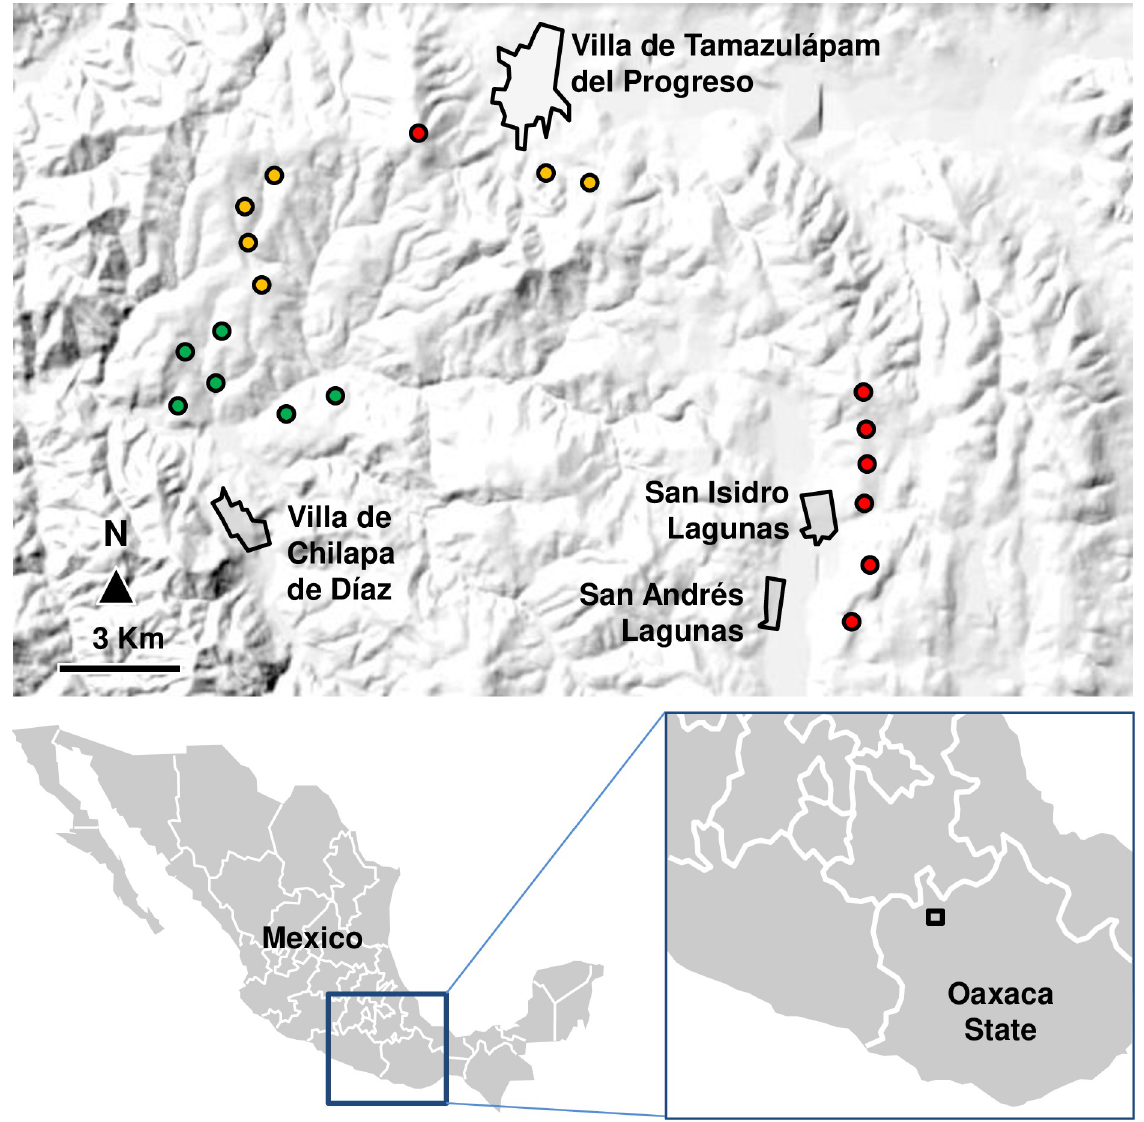
Fig 1. Study area map. Location of plots of our survey on an elevation map of the study area. Red dots: plots ranging between 2405 and 2500 meters above sea level (m asl), orange dots: plots ranging between 2110 and 2176 m asl, and green dots: plots ranging between 1850 and 1925 m asl. (When elevation was considered as categorical variable, red dots represented ‘high’ elevation category plots (~’2450 meters’ above sea level (m asl)); orange dots: ‘mid’ elevation category plots (~’2150 m’ asl); green dots: ‘low’ elevation category plots (~’1850 m’ asl). Names of the main municipalities of the study area are shown (San Isidro Lagunas is a village included in San Andre´s Lagunas municipality). Black line quadrate insert in Oaxaca State map corresponds approximately to the upper map with relief of the study